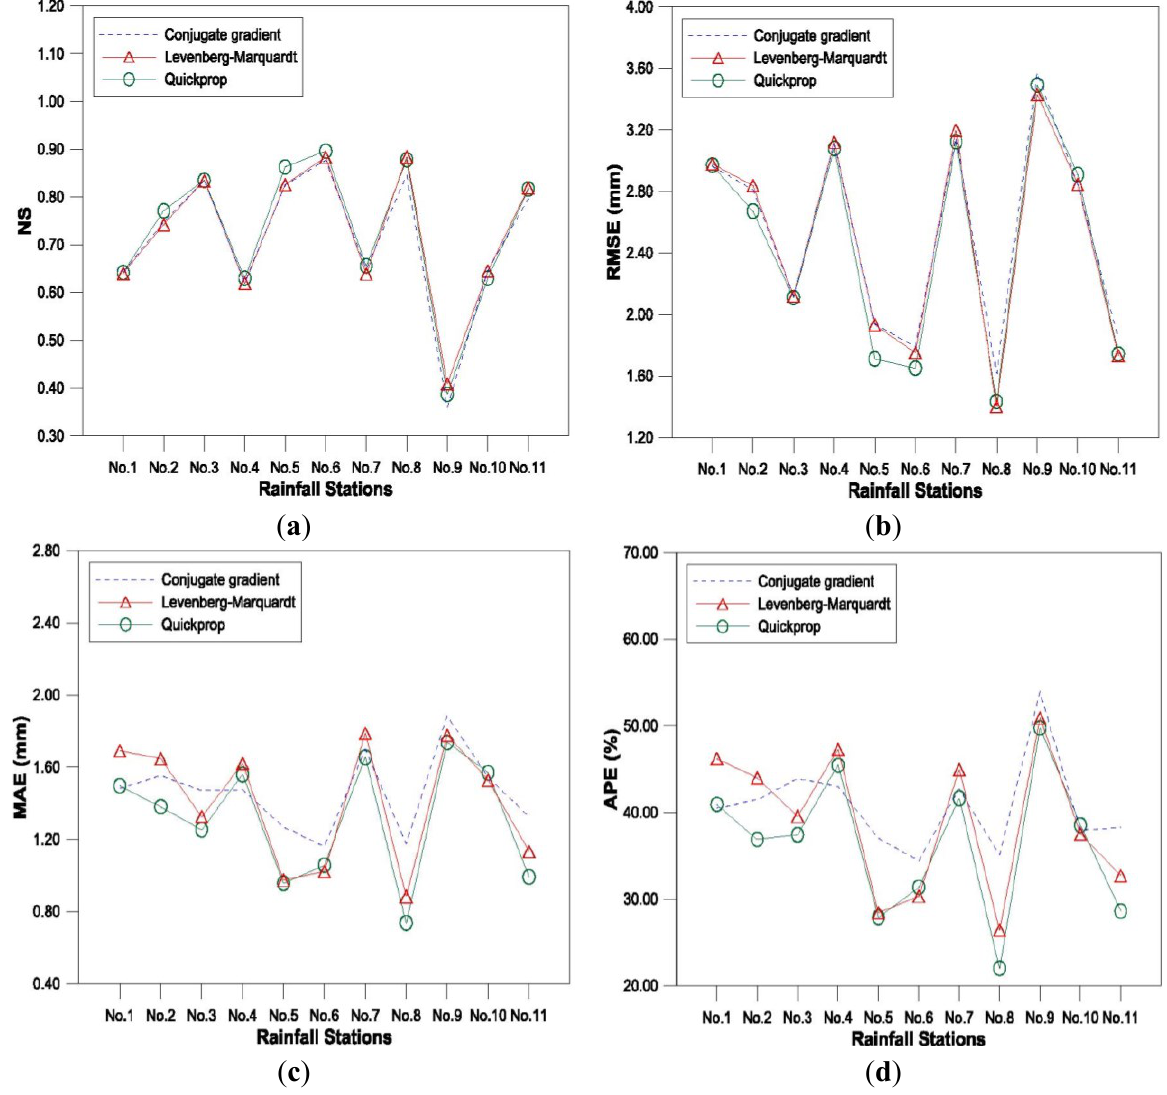
Figure 7. Influence of individual rainfall stations for three training algorithms of KSOFM1 (test period). ( a ) NS; ( b ) MAF; ( c ) RMSE; ( d )